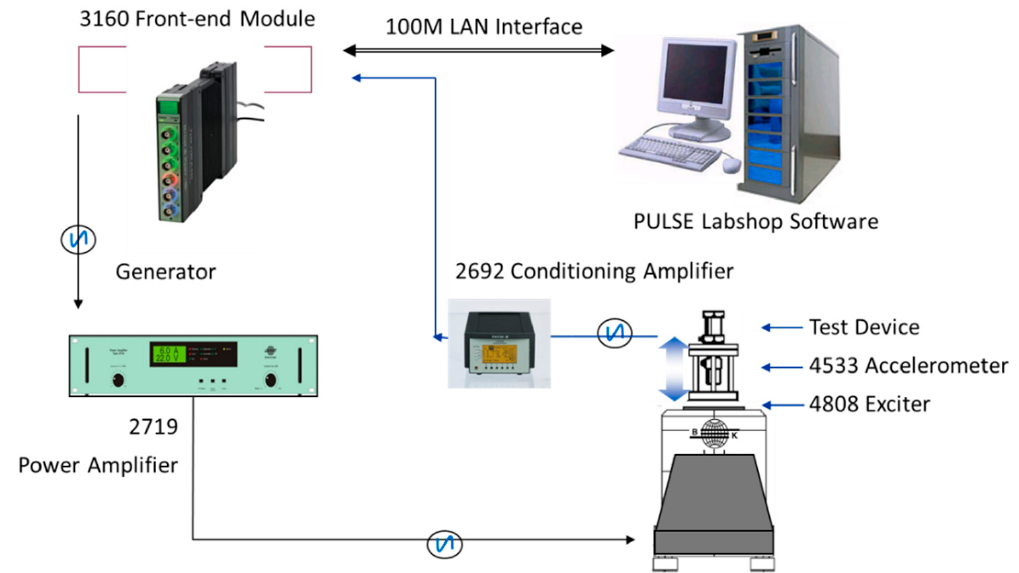
Figure 6. Experimental setup for output measurements.